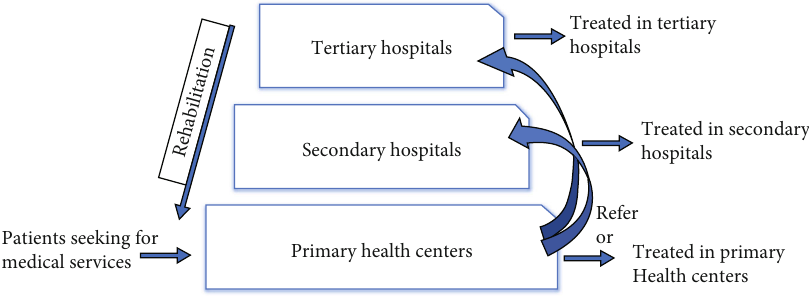
Figure 1: Procedural steps of q-ROF WPM.